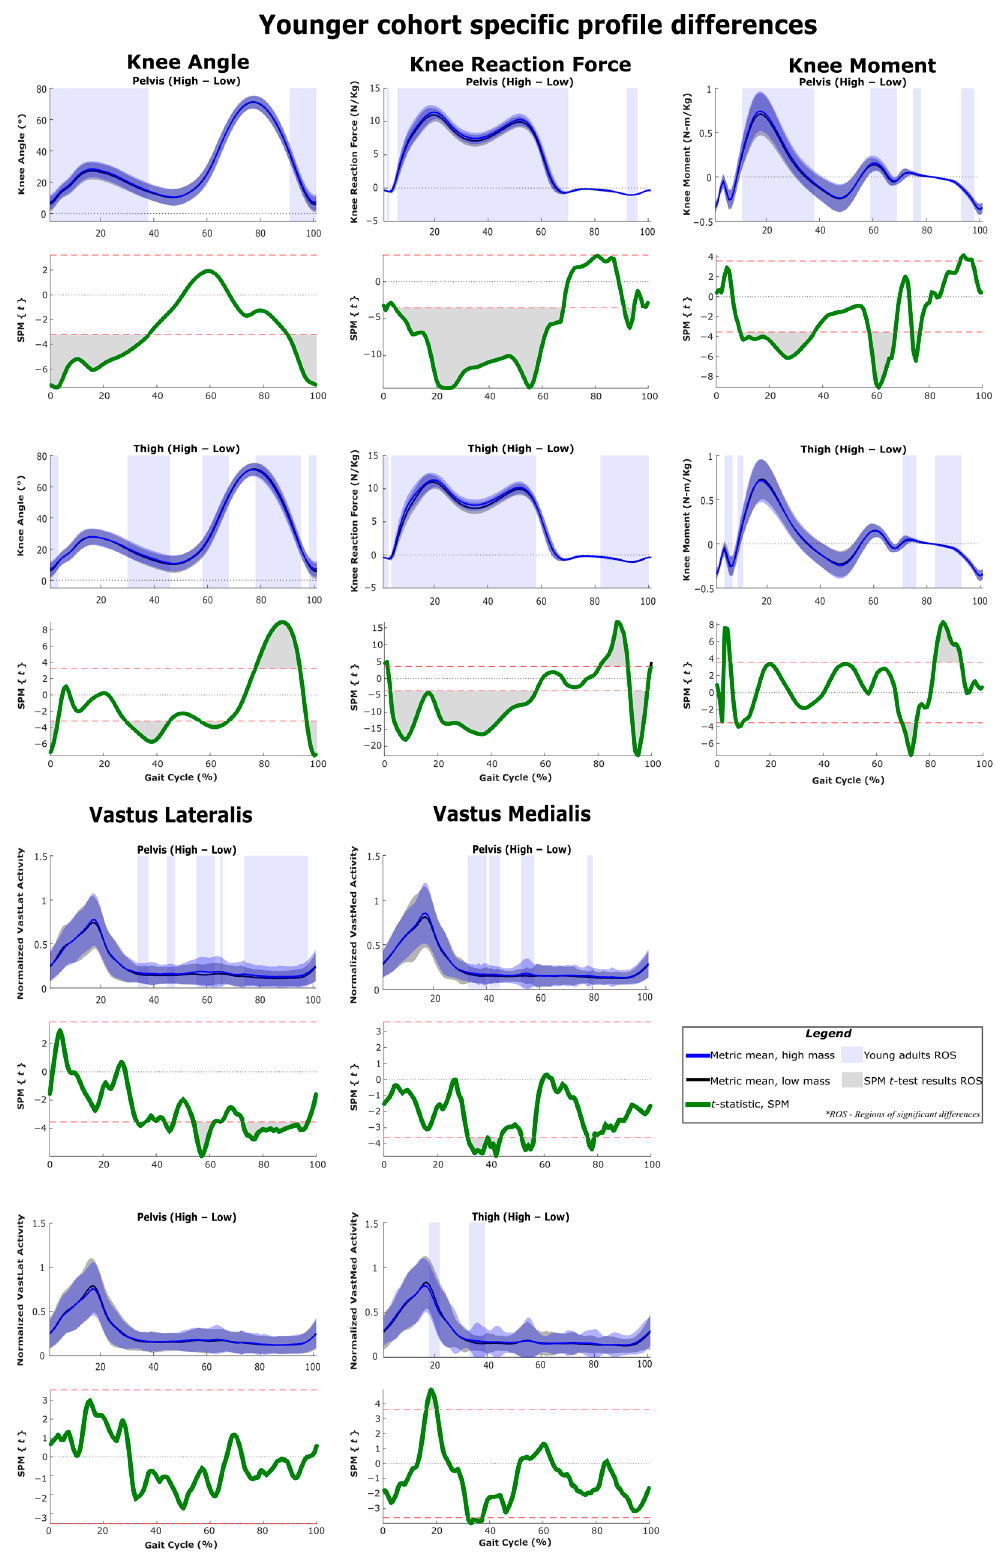
Figure 7. SPM t -test results and profile plots of the metrics, comparing low mass to high mass in the pelvis and thigh segments for participants in the younger cohort. Joint parameters are primarily related to the knee joint. The t -statistic is qualitatively identical to the effect size and can be used as an indicator of practical significance.